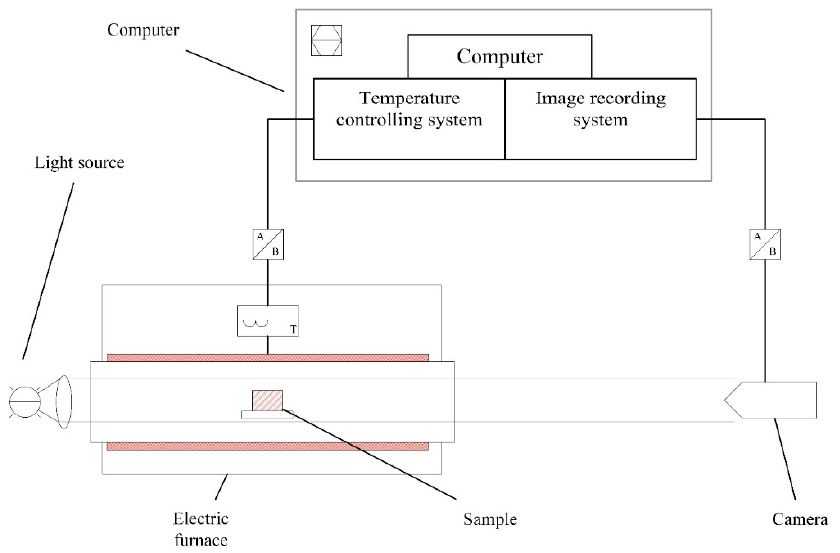
Figure 2. Schematic representation of a slag melting temperature characteristic tester for sintering analysis. Table 2. The interpretations of the characteristic temperatures correlated to sintering events.